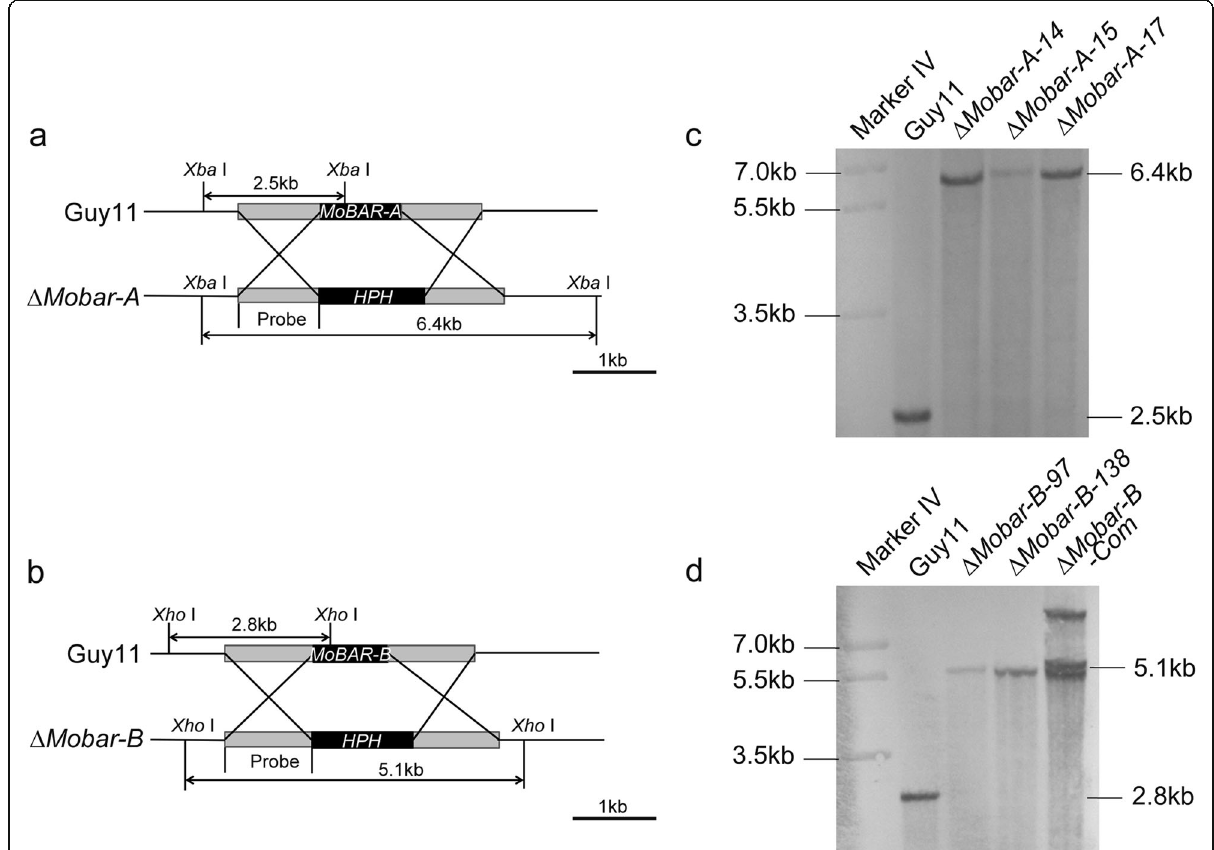
Fig. 3 Targeted deletion of MoBAR-A and MoBAR-B in Magnaporthe oryzae . a and b Schematic maps showing targeted disruption of MoBAR-A and MoBAR-B , respectively, with homologs recombination strategy. c and d Southern blot results showing successful replacement of MoBAR-A and MoBAR-B , respectively, by single insertion of hygromycin phosphotransferase (hph) ORF at MoBAR-A and MoBAR-B